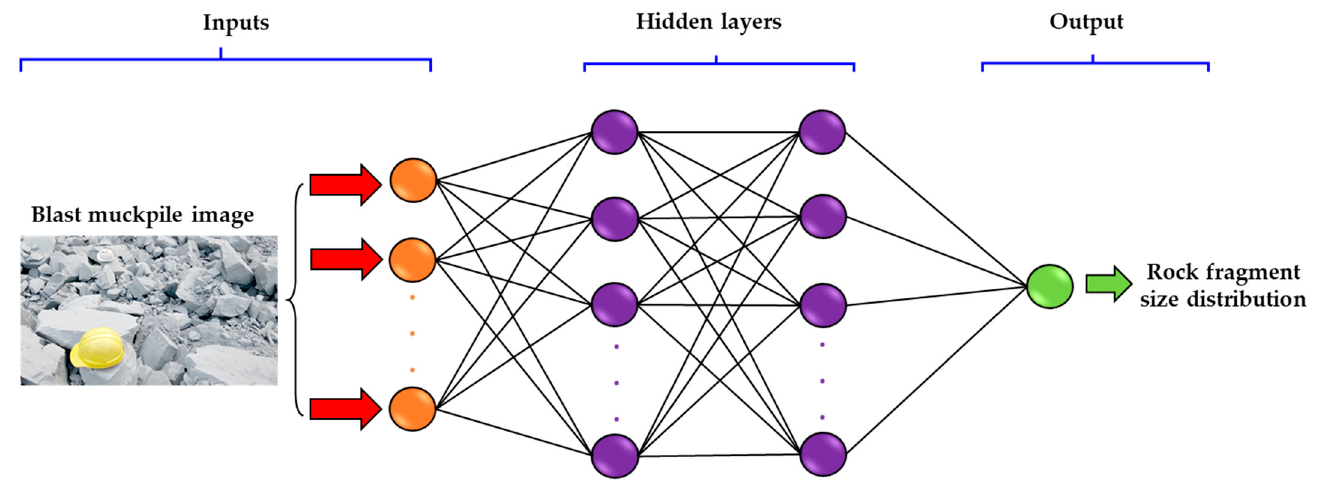
Figure 11. Schematic diagram of an ML model for predicting rock fragment size distributions.